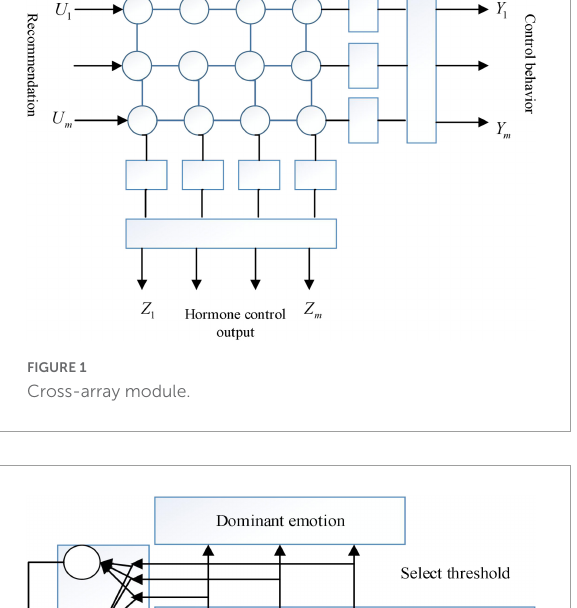
FIGURE1 Cross-array module.